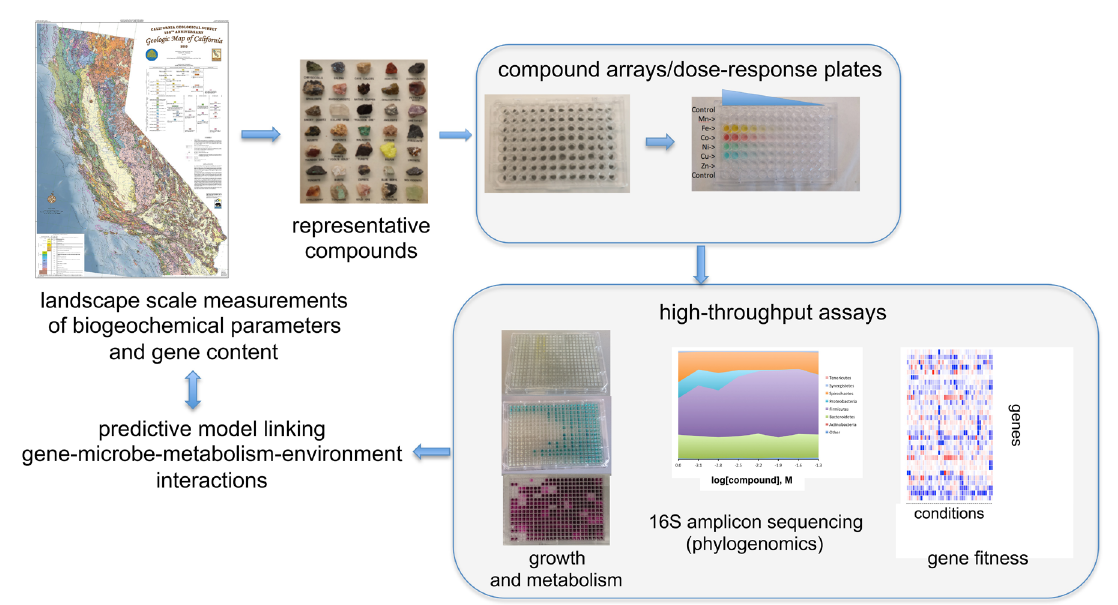
Figure 2. High-throughput cultivation pipelines can be used to evaluate gene-microbe-metabolism fitness in response to gradients of naturally occurring inorganic compounds. Measurements of metal content across rock, soil, and water samples can be obtained, and landscape-scale elemental maps can be constructed. Mineral samples and metal ions can be arrayed in microplates, and tagged- transposon pool assays, 16S amplicon sequencing, and metabolism-specific colorimetric assays can be employed to quantify the influence of concentrations of various metals on gene-microbe-metabolism fitness. Linking landscape-scale measurements of geochemistry to high- throughput laboratory measurements of microbial activity in response to geochemistry will enable higher-resolution biogeochemical